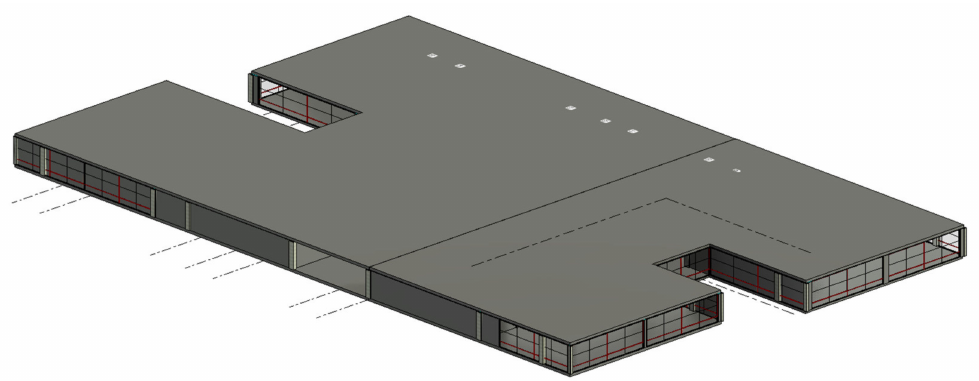
Figure A5. Case Study—H shape BIM